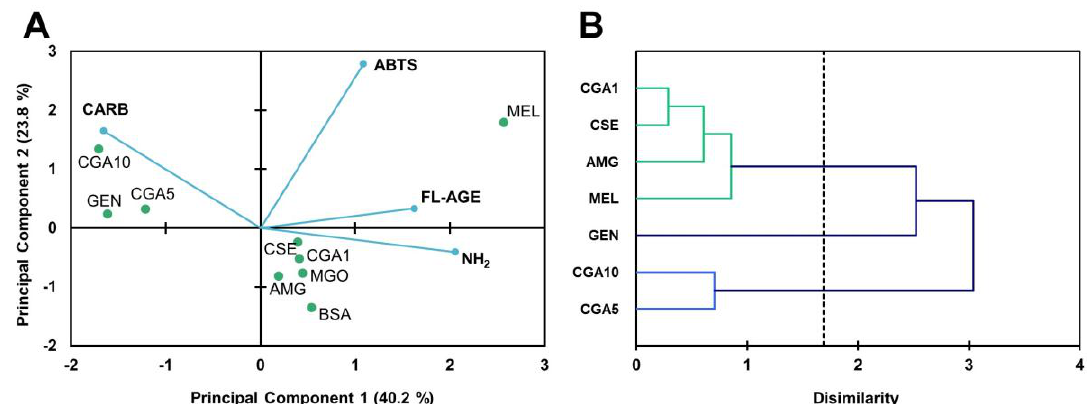
Figure 6. Biplot (scores of samples and load factors of each variable) of the principal component analysis (PCA) ( A ), including the content of free amino groups (NH 2 ), fructosamine (FRUCT), fluorescent AGE (FL-AGE), total AGE (T-AGE), and protein carbonyls (CARB) ( A ), and a dendrogram of the hierarchical cluster analysis of the glycation inhibitory activity ( B ) of the samples of the BSA-MGO glycation system (72 h incubation, 37 °C, pH 7.4) BSA: negative control; MGO: BSA + methylglyoxal; AMG: BSA + methylglyoxal + aminoguanidine; CSE: BSA + methylglyoxal + CSE (12,5 mg mL ‒1 ); CGA1: BSA + methylglyoxal + 1 mmol L ‒1 CGA; CGA5: BSA + methylglyoxal + 5 mmol L ‒1 CGA; CGA10: BSA + methylglyoxal + 10 mmol L ‒1 CGA; GEN: BSA + methylglyoxal + 5 mmol L ‒1 genistein; MEL: BSA + methylglyoxal + 5 mmol L ‒1 melatonin.